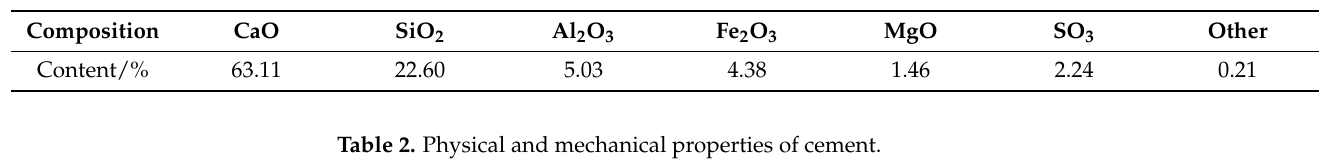
Table 1. Chemical composition of cement.